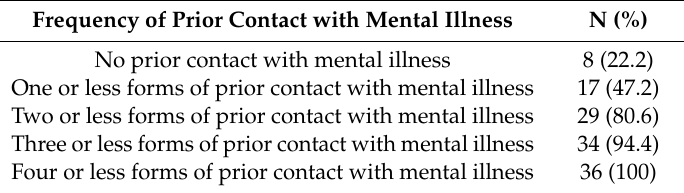
Table 2. Self-Reported Prior Contact with Mental